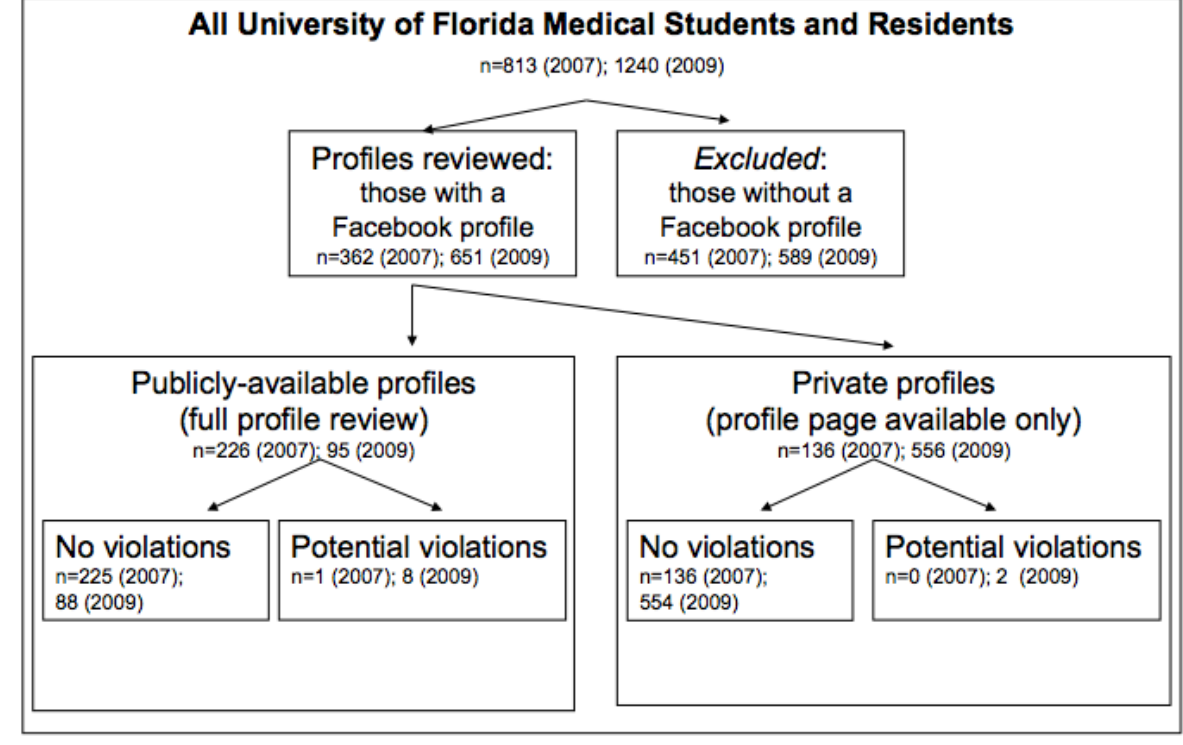
Figure 1. Enrollment of medical students and residents’Facebook